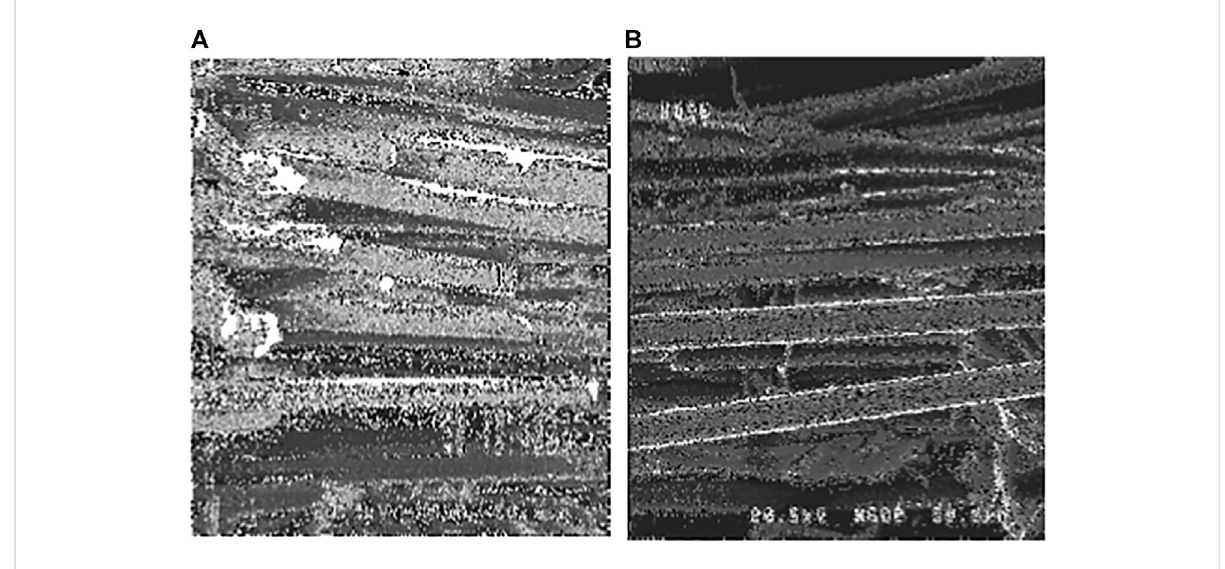
FIGURE 6 SEM image of (A) epoxy/10 fi berglass and (B) epoxy/15 fi